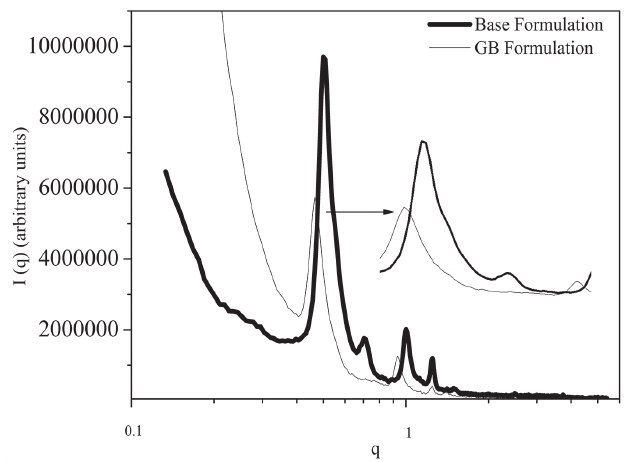
FIGURE 6 - SAXS assay results for the formulations containing or not the GB soft extract (q was determined in 1 / Å). A zoom of the image is indicate with the arrow.